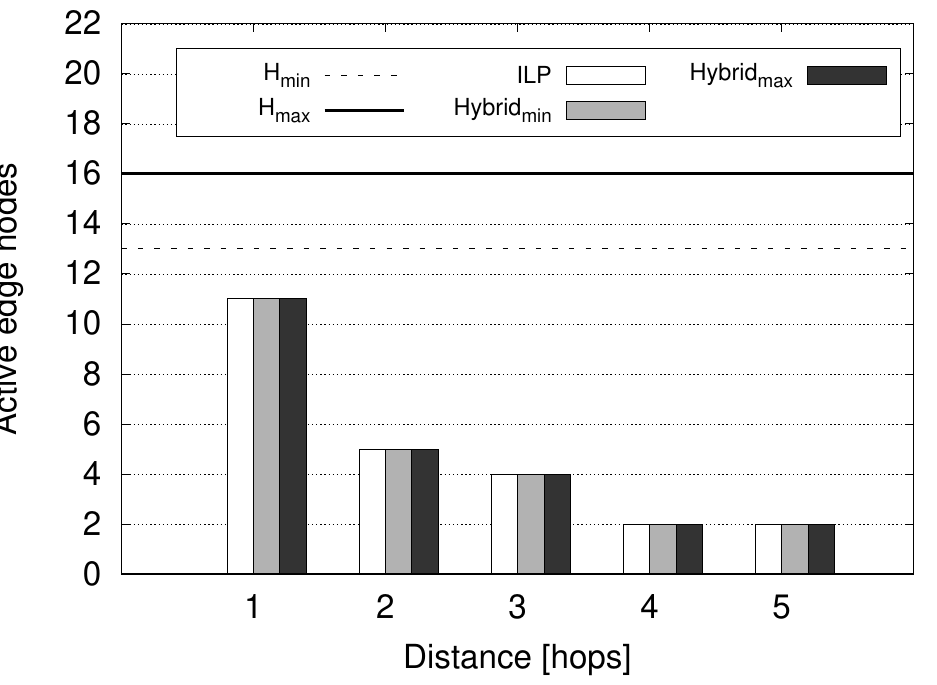
Figure 4. Total number of active edge nodes as a function of the allowed distance between RRUs and edge nodes for network N 20 : Maximum and minimum costs of the hybrid results are reported after both phases.